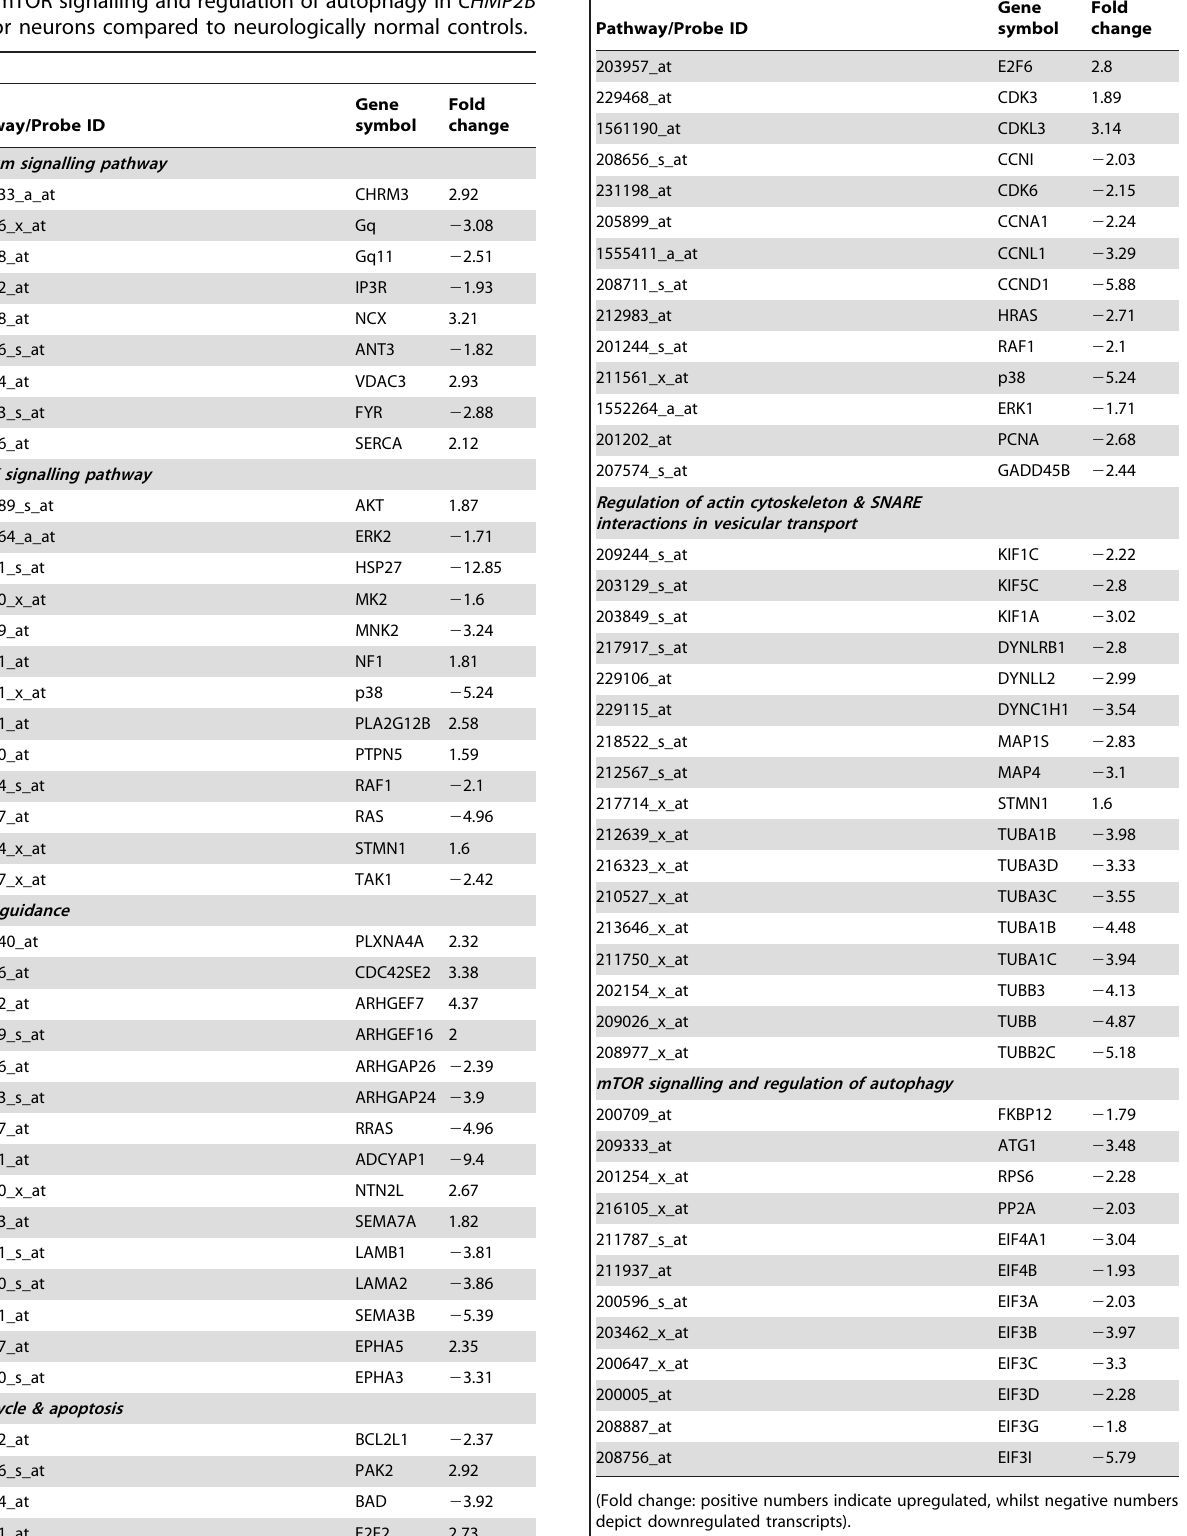
Table 4. Genes altered in calcium signalling, MAPK signalling, axon guidance, cell cycle and apoptosis, regulation of actin cytoskeleton and SNARE interactions in vesicular transport, and mTOR signalling and regulation of autophagy in CHMP2B motor neurons compared to neurologically normal controls. Pathway/Probe